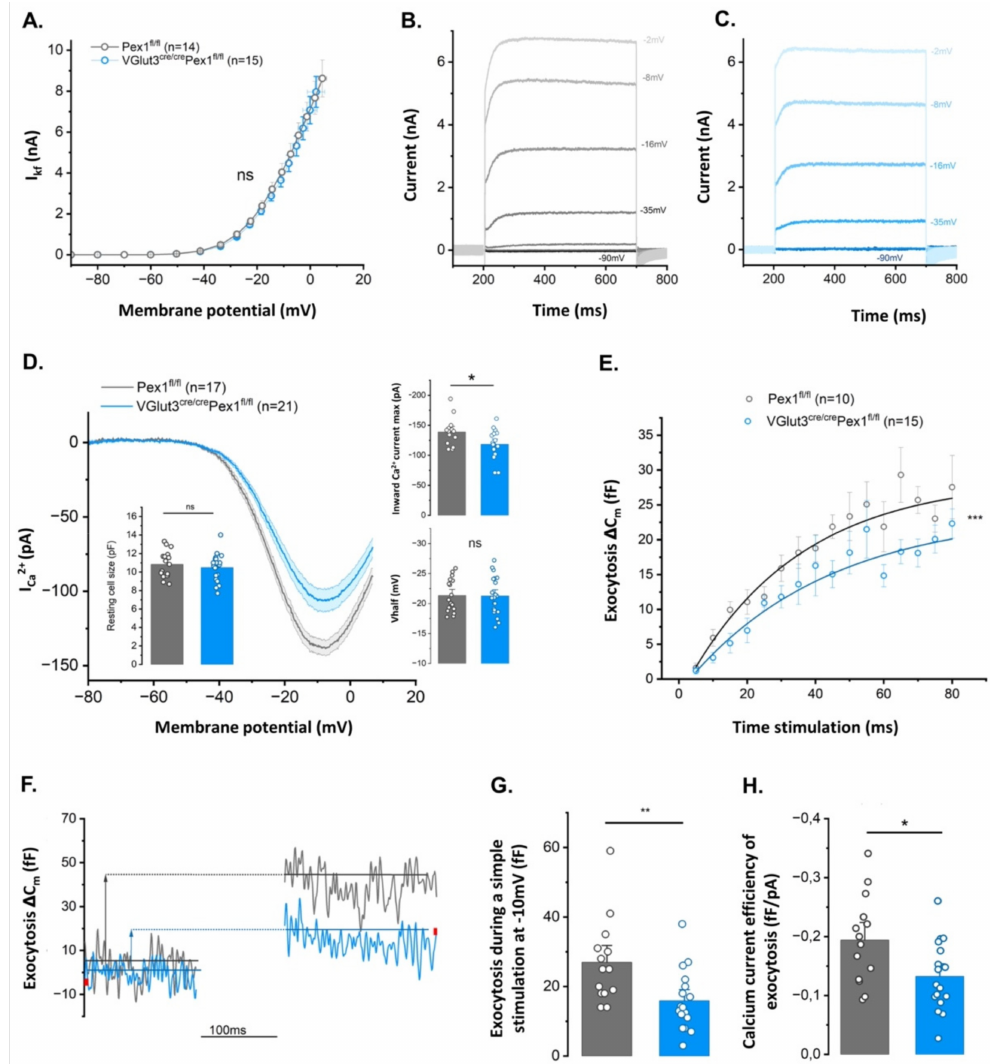
Figure 6. Lack of Pex1 in P18–P21 IHCs affects Ca 2+ currents and exocytosis while no alteration in BK channels is observed. ( A ) Comparative BK current-voltage curve (Table S14, n = 14 and 15, respectively in P18–P21 Pex1 fl/fl and VGlut3 cre/cre Pex1 fl/fl ; ns p = 0.65). IV curve is obtained with 20 ms depolarizing steps from − 90 mV to +70 mV with an increment of +10 mV for each depolarizing step with IK,f measured at 2 ms from the onset of the depolarizing step; ( B , C ) Potassium current responses from Pex1 fl/fl IHCs (grey) and VGlut3 cre/cre Pex1 fl/fl (blue). Currents were elicited using 500 ms depolarizing steps from − 90 mV to +70 mV with an increment of +10 mV for each depolarizing step; ( D ) Comparative Ca 2+ current-voltage curve (Table S14, IV; n = 17 and 21, respectively for P21–P25 Pex1 fl/fl in grey and VGlut3 cre/cre Pex1 fl/fl in blue). IV curve is obtained with a ramp protocol starting at − 80 mV to 10 mV with an increase of 1 mV each millisecond. Values in the right graphs indicate the max inward Ca 2+ current and the V1/2 of the IV curve. The peak of the Ca 2+ current was significantly higher in Pex1 fl/fl IHCs compared to VGlut3 cre/cre Pex1 fl/fl IHCs (Table S14; unpaired t -test, * p = 0.025). While the Ca 2+ current is decreased there is no shift in the activation of the Ca 2+ channels of VGlut3 cre/cre Pex1 fl/fl IHCs (Table S14; unpaired t -test, ns p = 0.93). Insert graph in left: comparative mean IHC resting membrane capacitance, measured at − 70 mV, in whole-cell patch clamp configuration (Table S14; n = 17 and 21, respectively in Pex1 fl/fl and VGlut3 cre/cre Pex1 fl/fl ; unpaired t -test, ns p = 0.47); ( E ) Comparative kinetics of exocytosis show a significant decrease of the fast exocytosis of the Readily Releasable Pool of vesicles in VGlut3 cre/cre Pex1 fl/fl IHCs (2way ANOVA, *** p = 7.6 × 10 − 8 ). Exocytosis was elicited with voltage steps from − 80 mV to − 10 mV (corresponding to the max inward Ca 2+ current) with increasing duration from 5 ms to 80 ms. ( F )